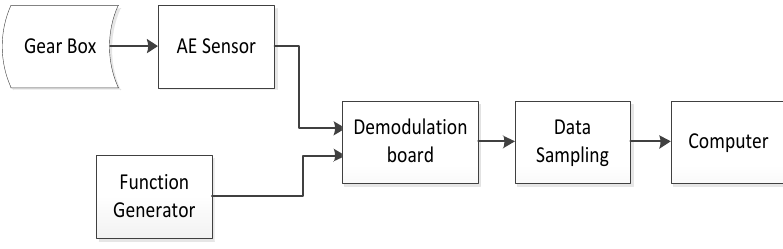
Figure 3. The AE signal acquisition and preprocessing